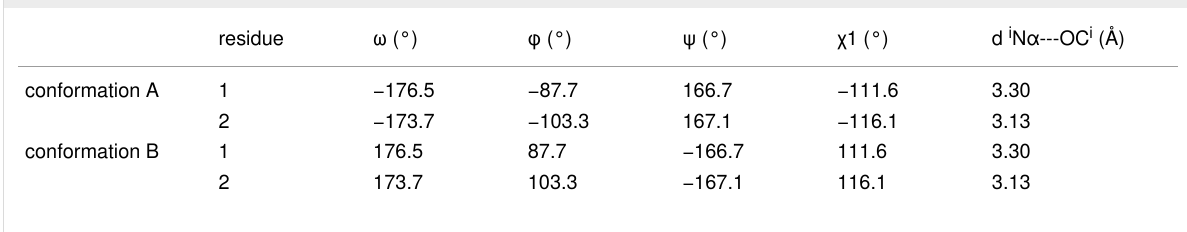
Table 2: Dihedral angles observed in dimer 2 crystal